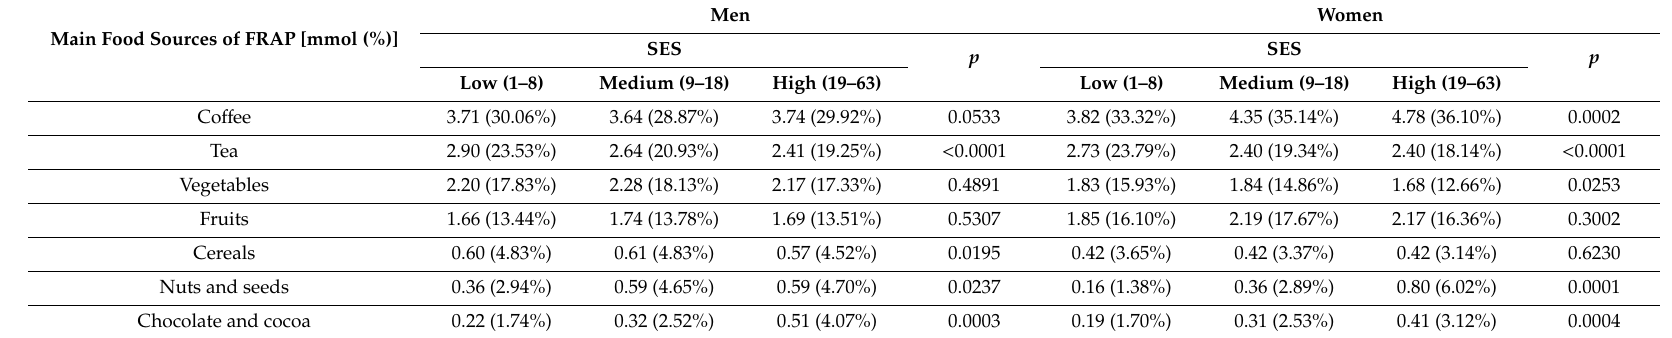
Table 5. Main food sources of dietary total antioxidant capacity, according to socioeconomic status (SES) score. Main Food Sources of FRAP [mmol